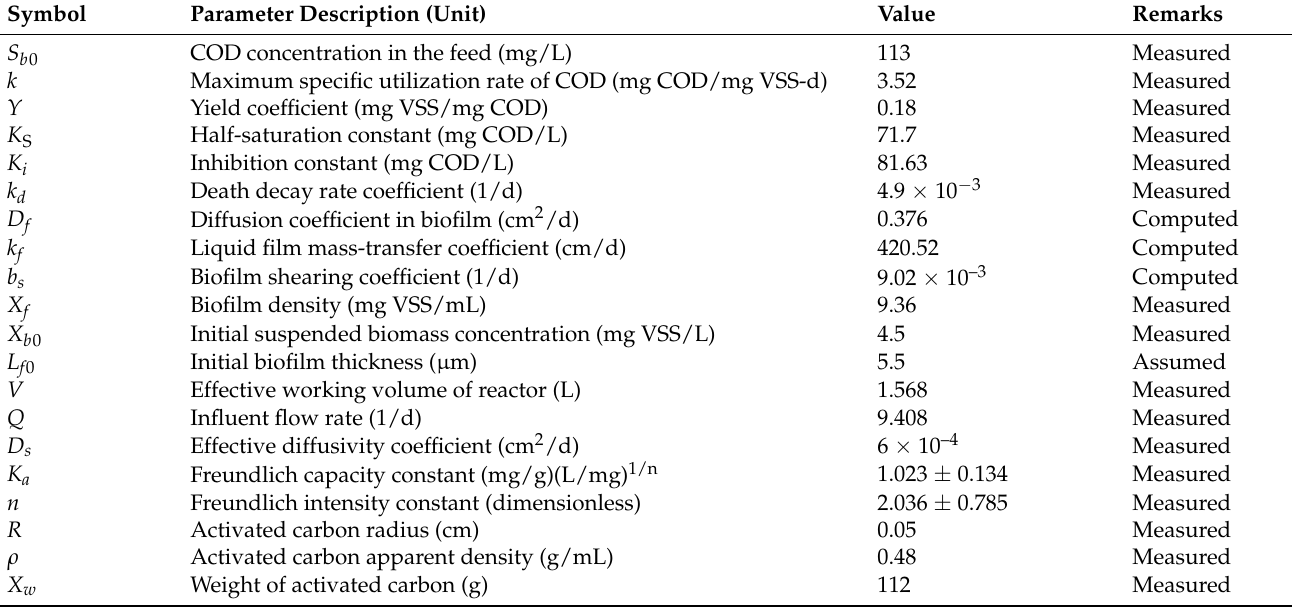
Table 3. Operational and biokinetic constants as input parameters to model